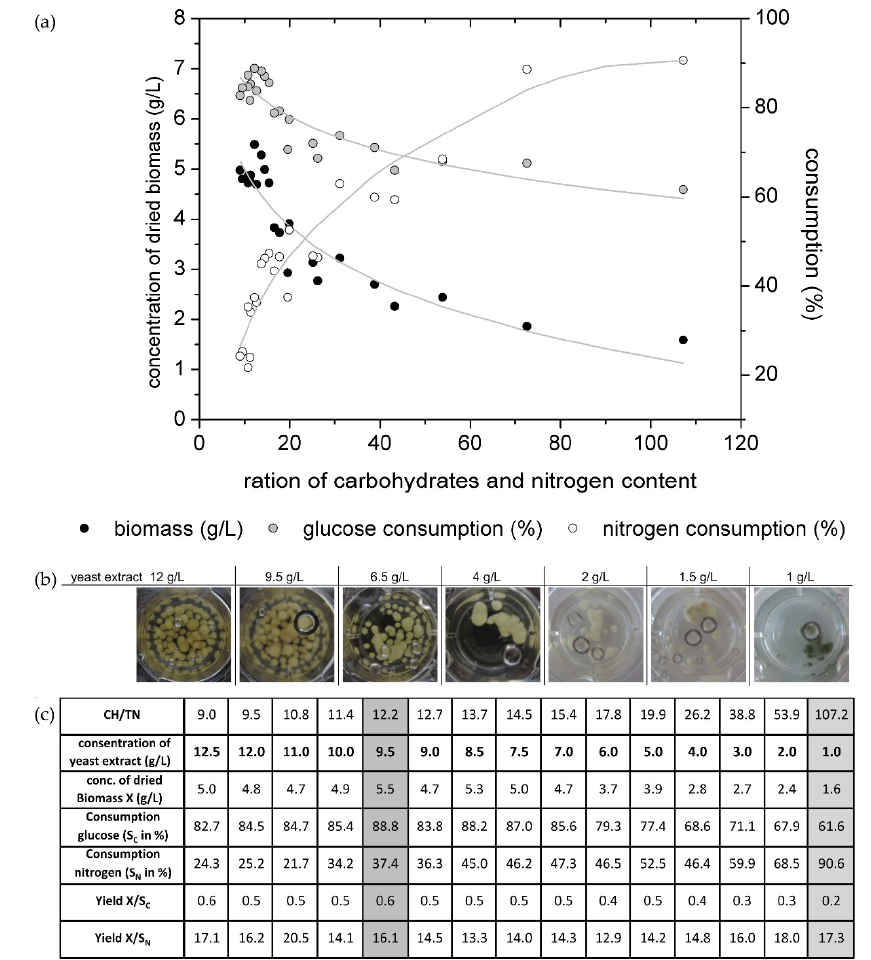
Figure 2. ( a ) Biomass production, glucose and nitrogen consumption of Chlorociboria aeruginascens after 14 days of cultivation in 12-well plates with different initial carbohydrate / nitrogen ratios. ( b ) Selected examples of wells with different initial yeast extract contents and different biomass production (well with 1 to 2 g / L are photographed against a white background for better valuation of the pigment production by the fungus). ( c ) Overview of selected data from the cultivation in 10 g / L glucose with variations of yeast extract concentration to different CH / TN ratios, best combination of C and N source for biomass production (marked in dark grey) and best combination for pigmentation (marked in light grey).